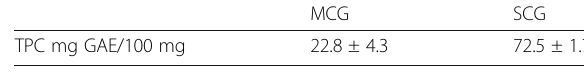
Table 2 Comparison of the total phenol content (TPC) of MSG and SCG extracts